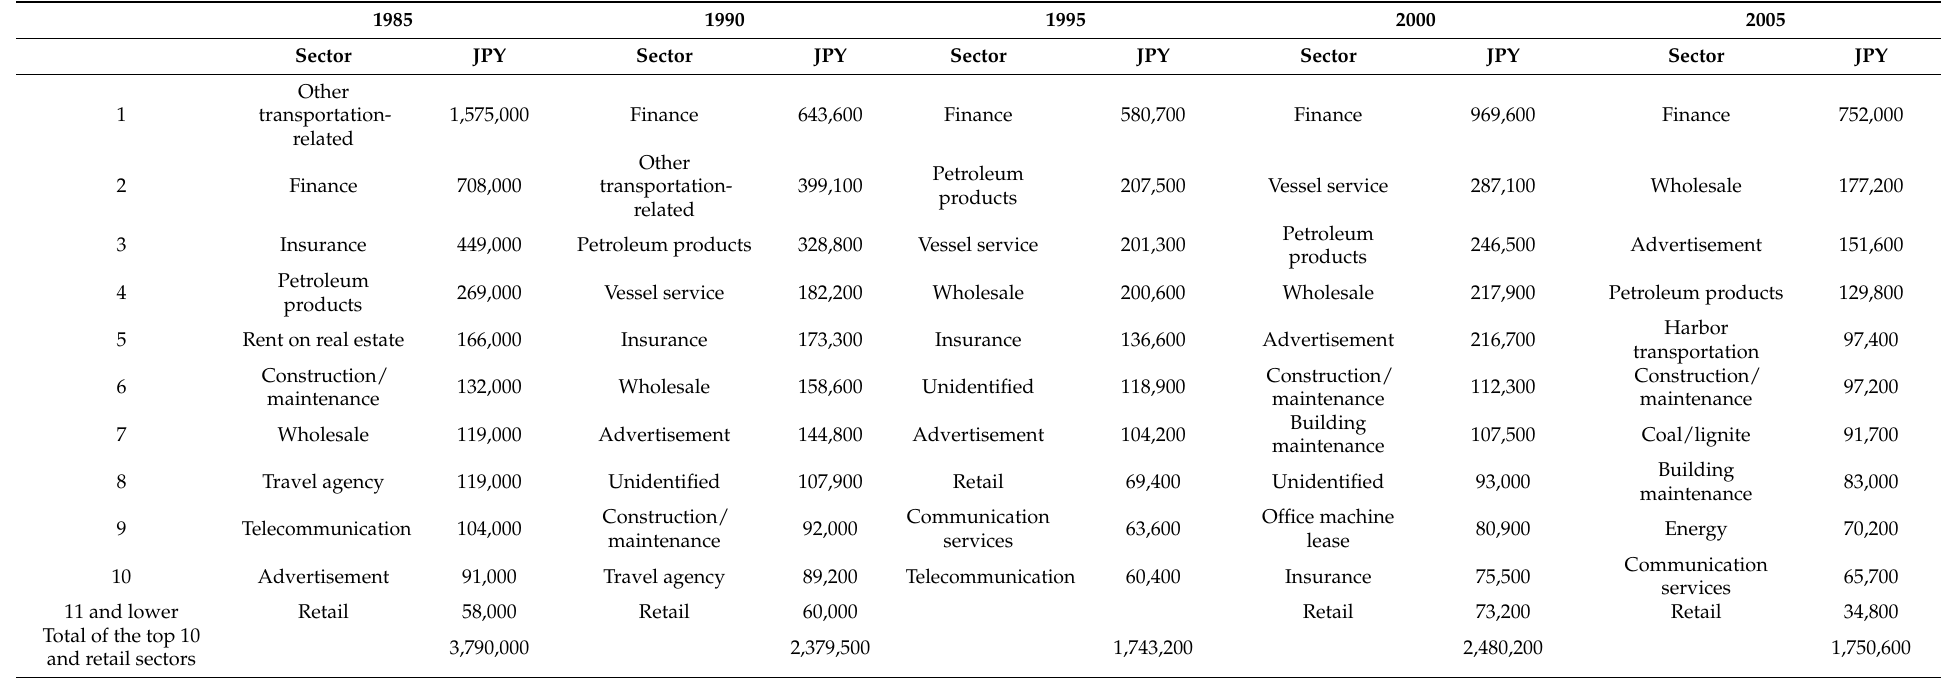
Table 2. Sectors in Tokyo that benefited from the demand increase in the inland navigation